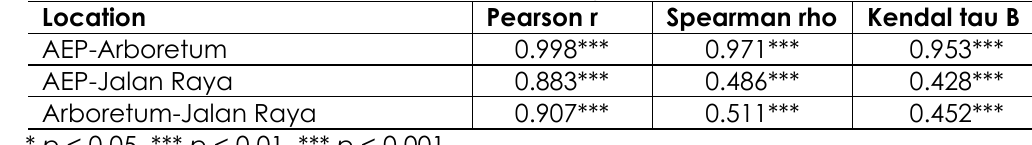
Table 1. Landscape Elements Correlation Analysis collected by Google Vision API.